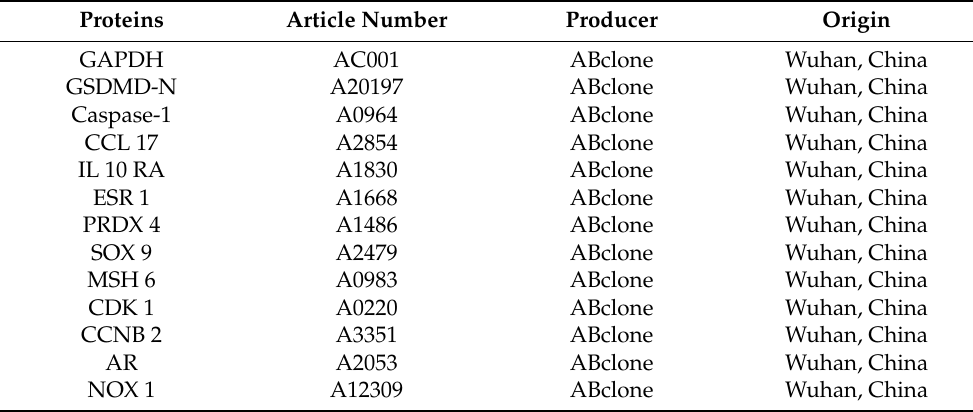
Table 1. Primary